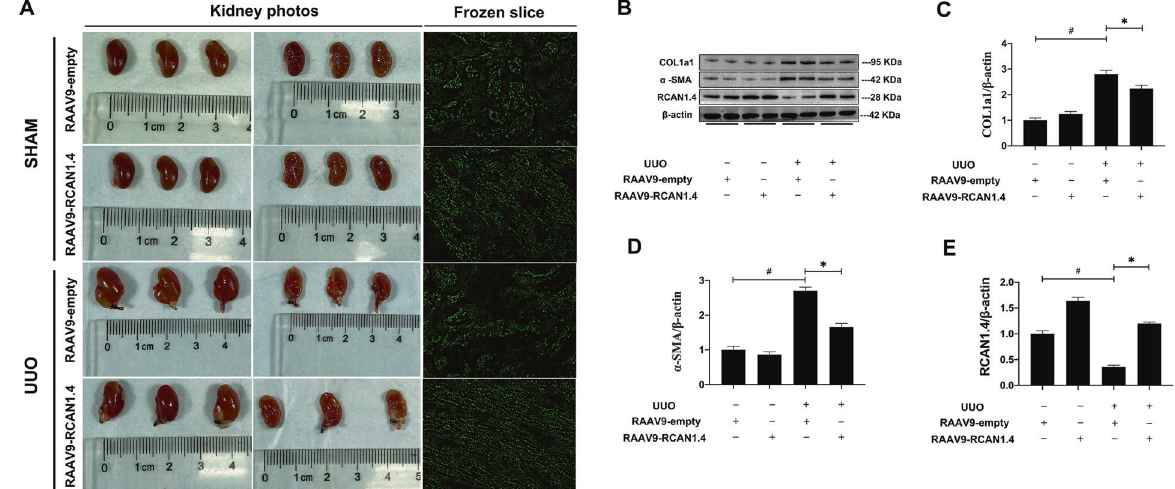
Fig. 3 Forced RCAN1.4 overexpression by rAAV9-packed RCAN1.4 over-expression plasm alleviated UUO-induced renal fi brosis. A Macroscopic observation of fresh kidney tissues by camera and fl uorescence microscope; B Representative blot of RCAN1.4, COL1a1, α -SMA, and β -actin; C COL1a1/ β -actin ratio; D α -SMA/ β -actin ratio; E RCAN1.4/ β -actin ratio. The results are expressed as the mean ± standard error of the mean (S.E.M.) for 3 – 4 independent experiments. * p < 0.05, # p < 0.05, as indicated.